Question: Give a one-sentence summary of this figure.
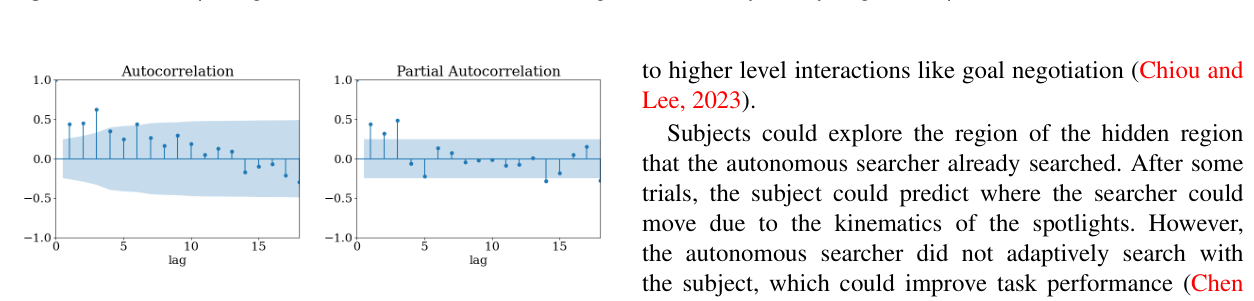
Answer: The Autocorrelation Function and Partial Autocorrelation Function plots of the residuals for Group 0 indicate lags 1 through 3 are likely necessary to capture the remaining error.